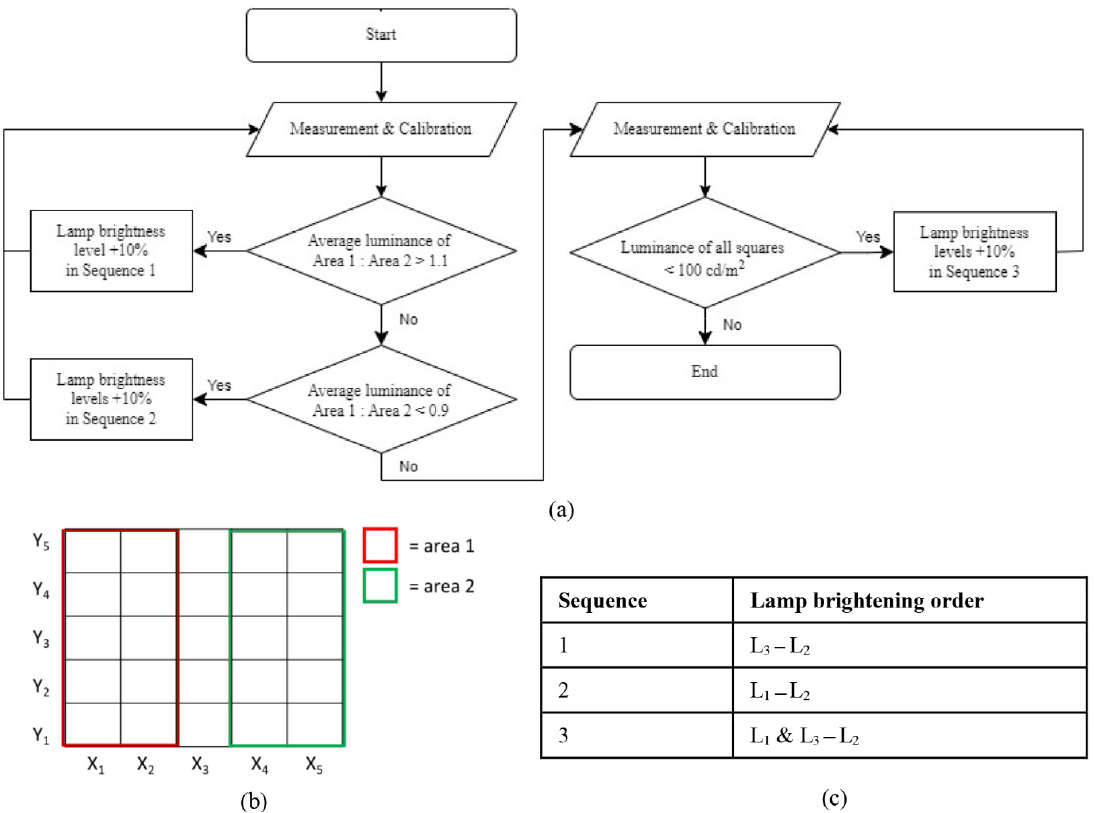
Figure 6. ( a ) The LCS flow diagram for scheme 1; ( b ) The layout of the room; ( c ) The sequence of the lamps